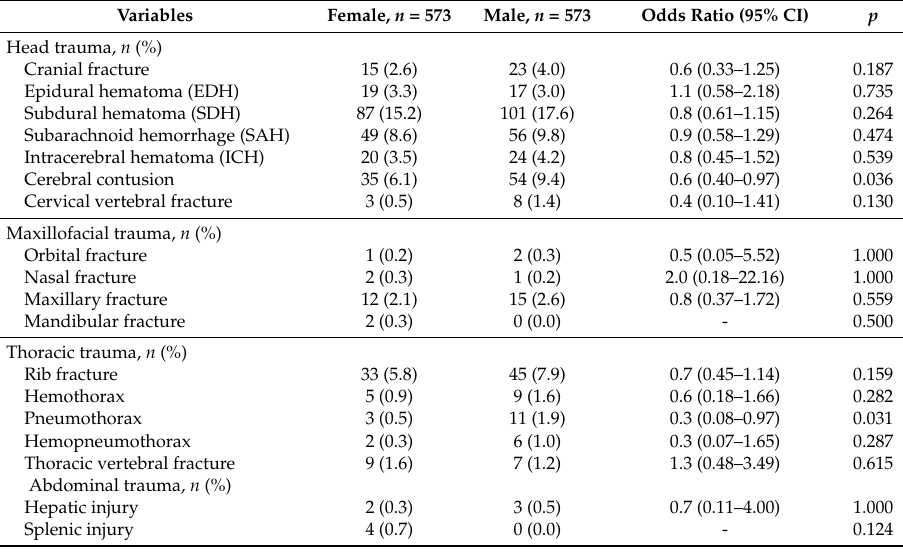
Table A1. Trauma patterns in different body parts of male and female patients with high-risk OSTA